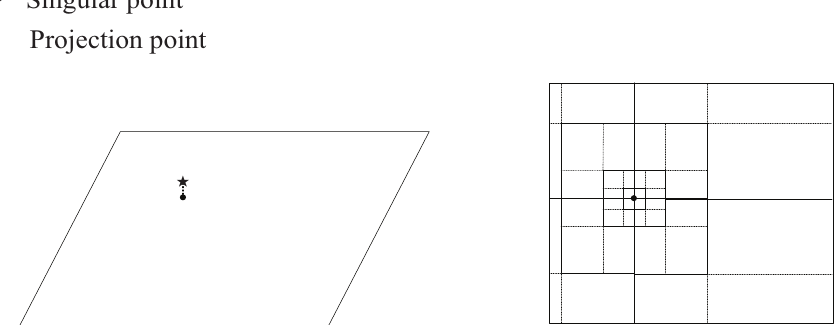
Figure 2. The partition method in Case I (left: location of the singular point z ∗ and projection point z . right: the nonuniform grid).